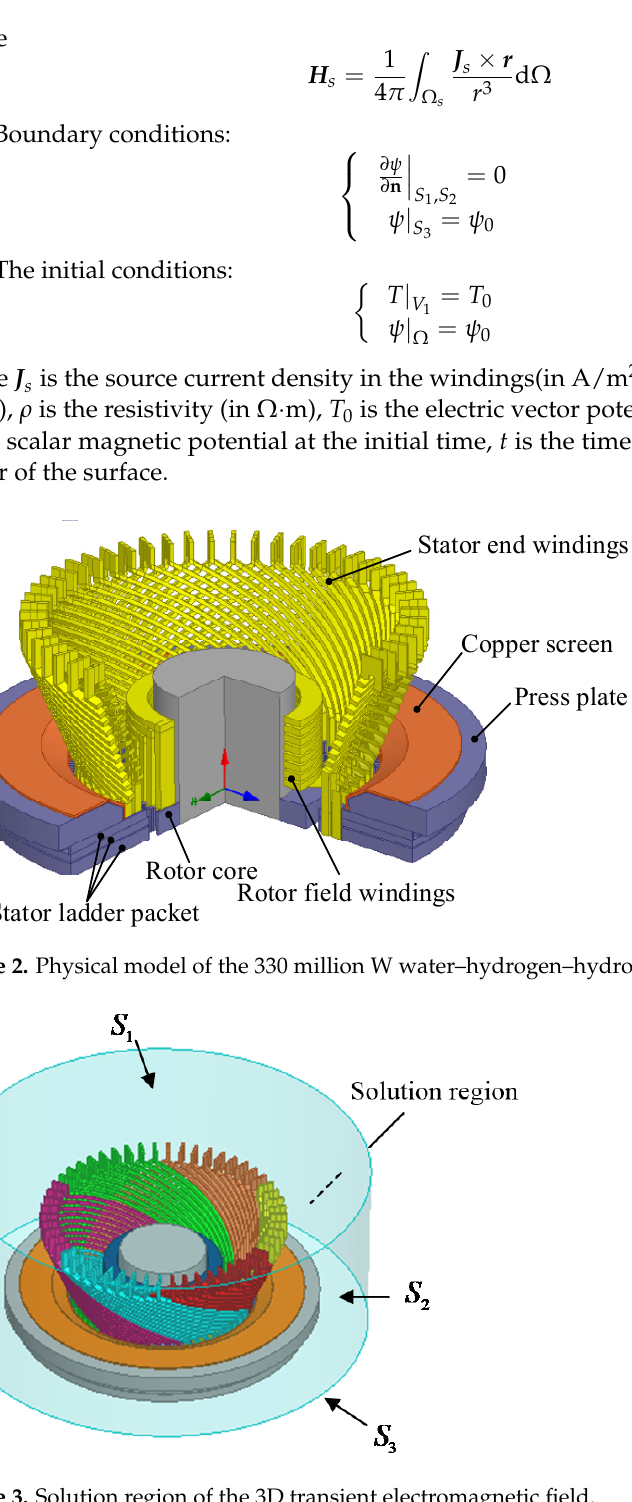
Figure 3. Solution region of the 3D transient electromagnetic field.